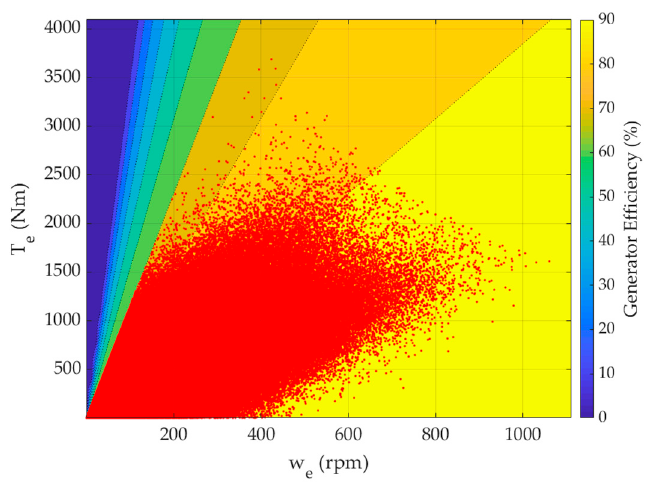
Figure 13. Constrained March generating contour map.